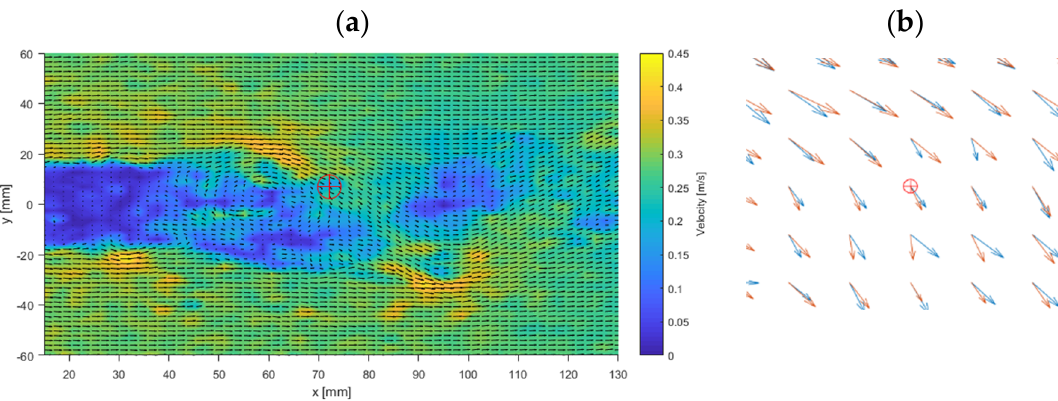
Figure 3. ( a ) Instantaneous snapshot at t = 1 with point selected for validation, VP 1 . ( b ) zoomed view of VP 1 at t fr = 1 (blue) and t fr = 10 (red).